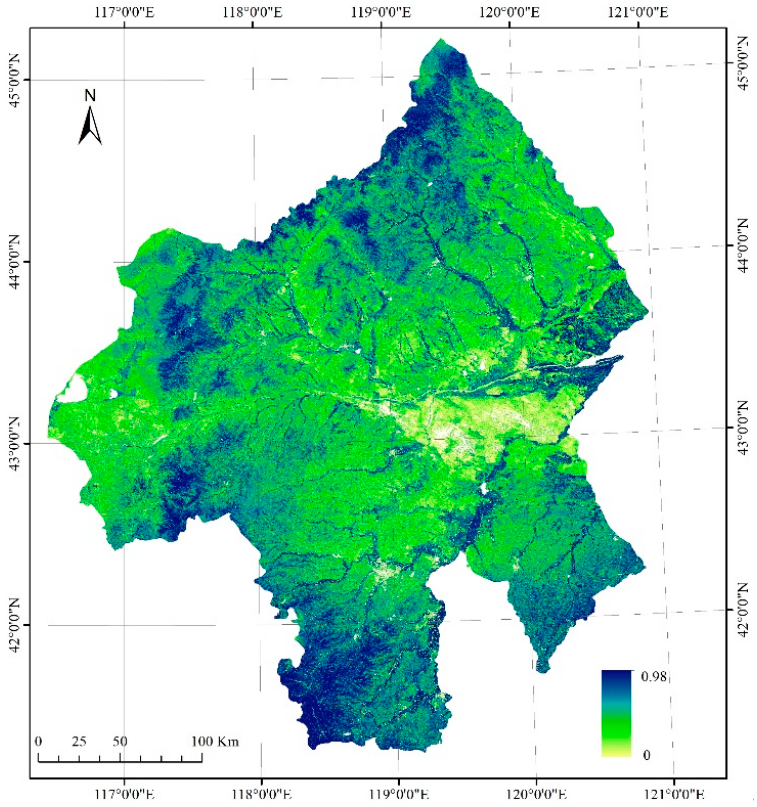
Figure 6. The canopy closure estimation results using Sentinel-2 images based on BEVIs.